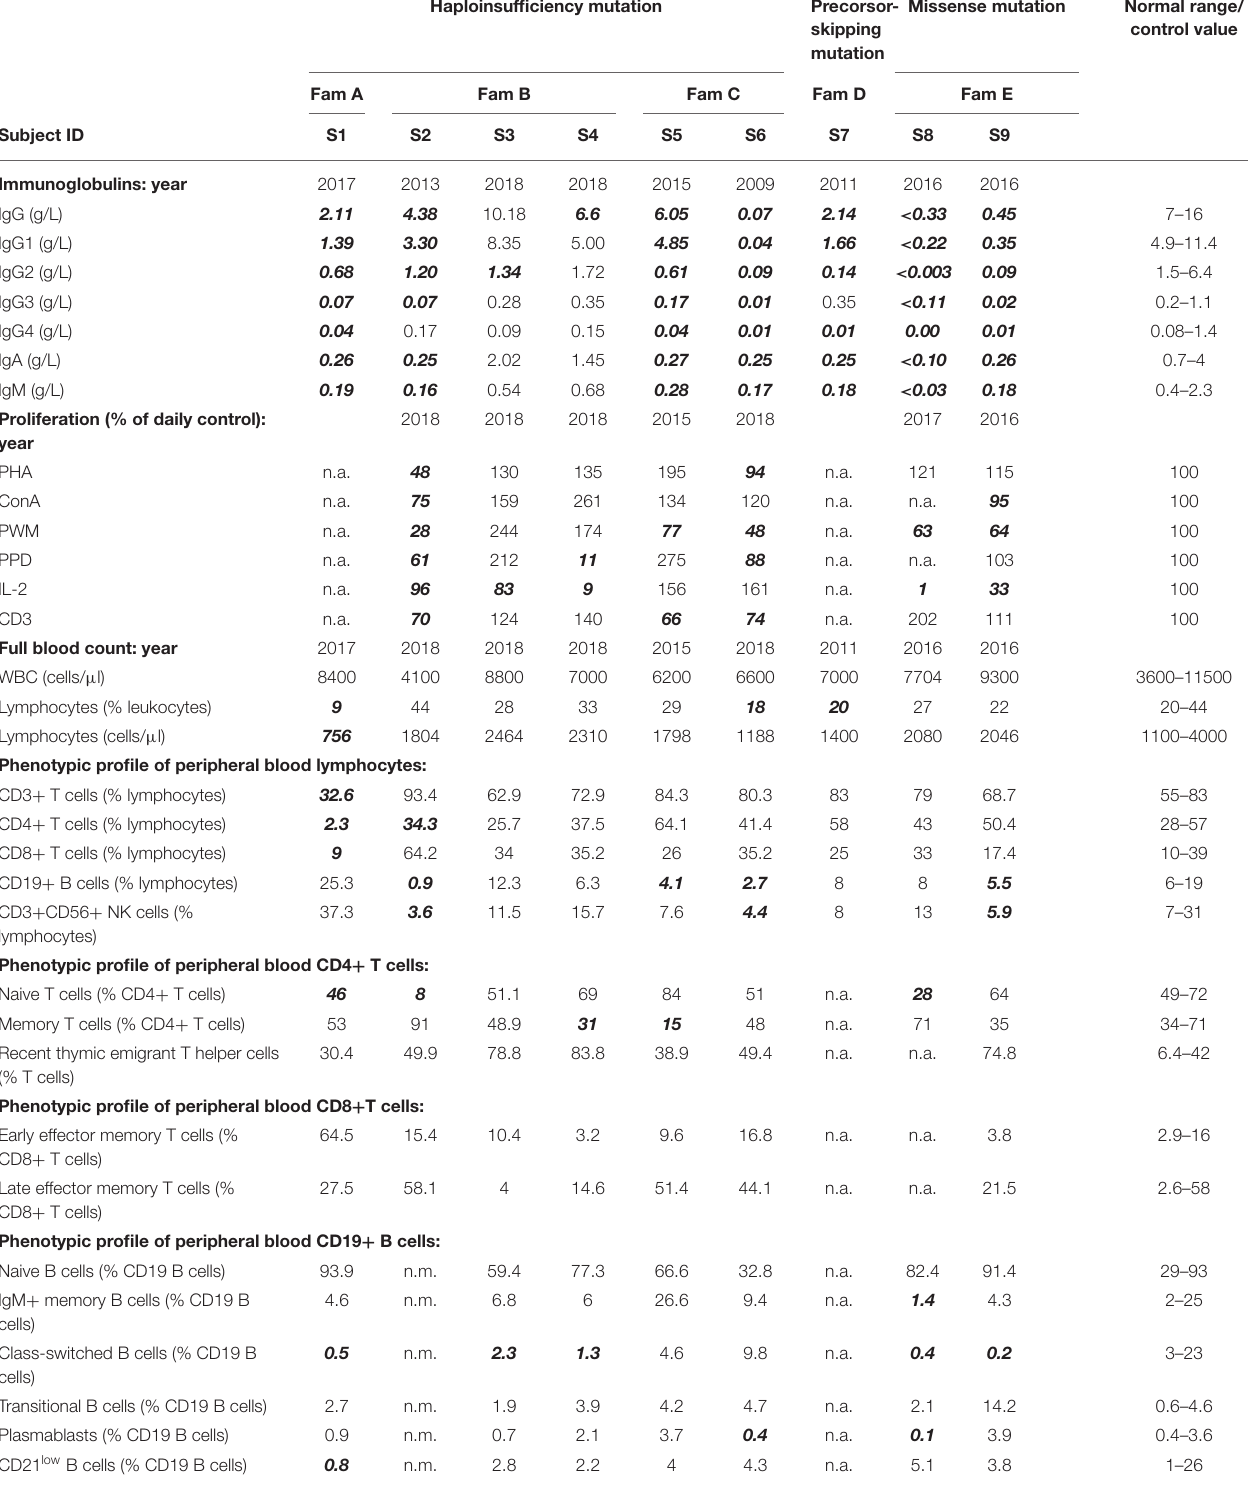
TABLE 2 | Immunological investigations of subjects with NFKB1